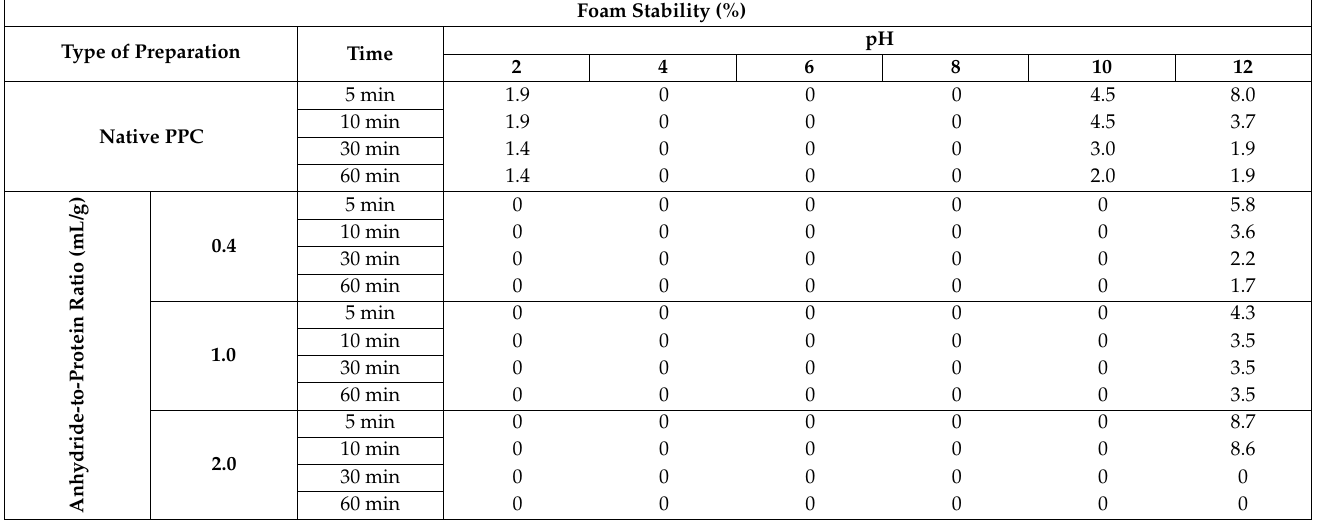
Table 4. Results of the foam stability (FS, %) at different pH of native and acetylated PPC. Foam Stability (%) Type of